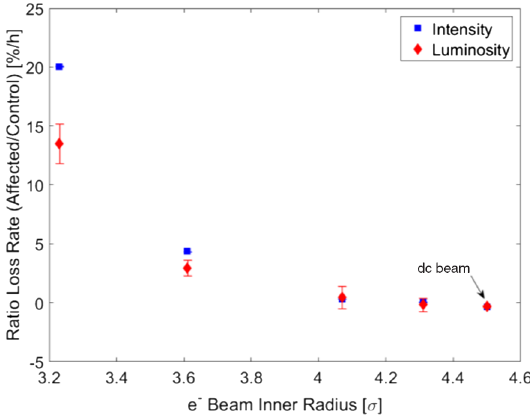
FIG. 16. The slope (absolute value) of the intensity and luminosity ratio of the two bunch trains as a function of the hollow beam inner radius. The error bar is from the fitting